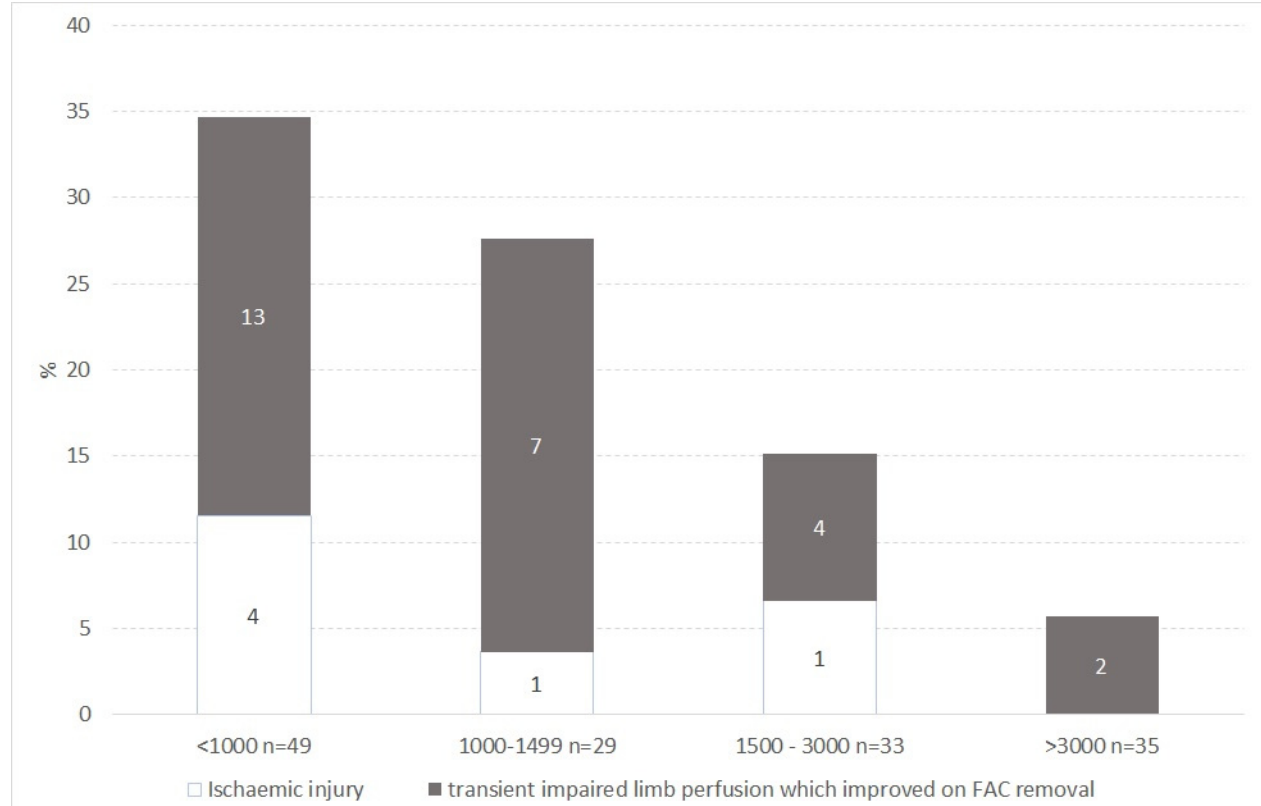
# Data shown as Median and interquartile range.